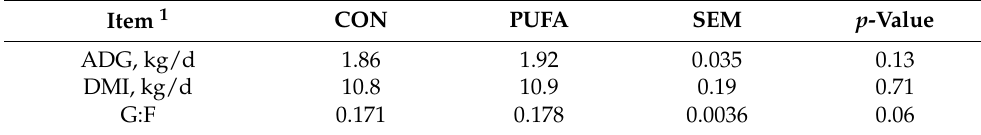
Table 4. Effects of supplementing cows with either 155 g DM/d EnerGII (CON) or 80 g DM/d Strata + 80 g DM/d Prequel (PUFA) for the last 77 ± 6 d of gestation on steer progeny finishing